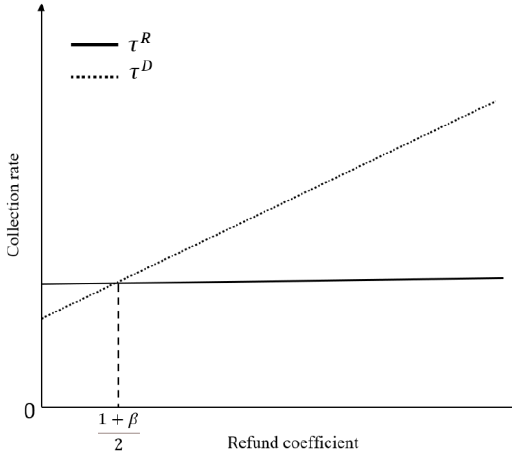
Figure 3. Impact of the refund coefficient on the collection rate.